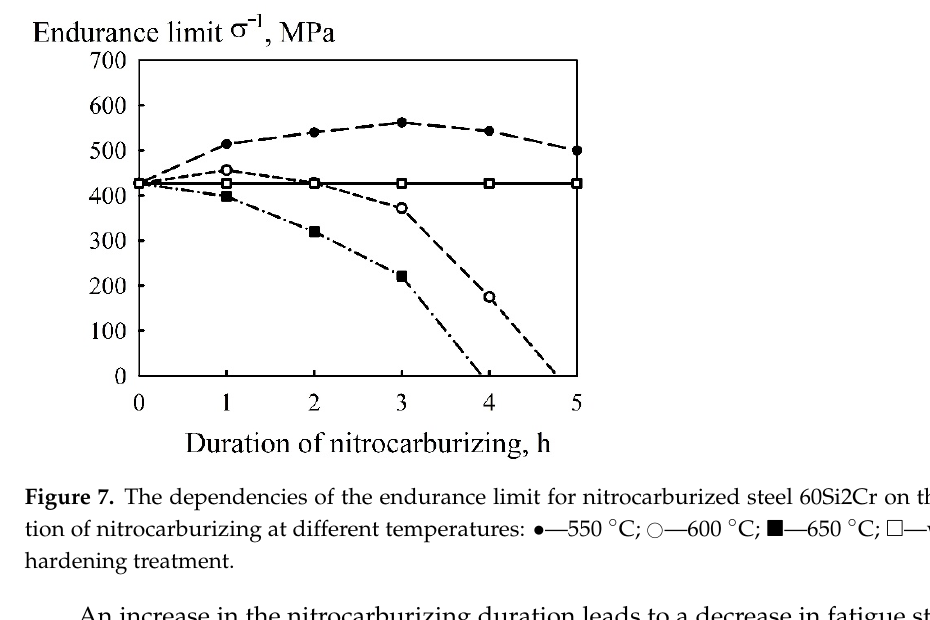
—600 ◦ C; (cid:4) —650 ◦ C; (cid:3) —without (cid:35)